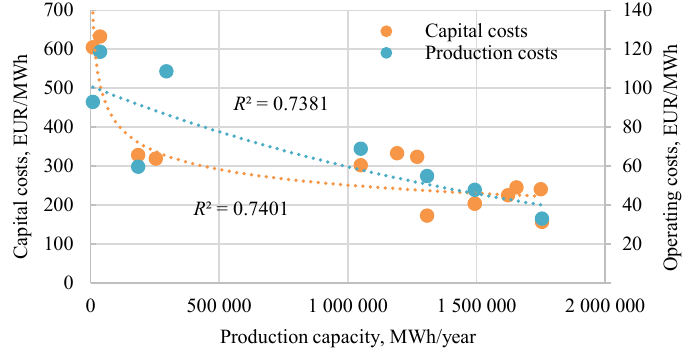
Fig. 4. Correlation between total capital and operation costs with plant production